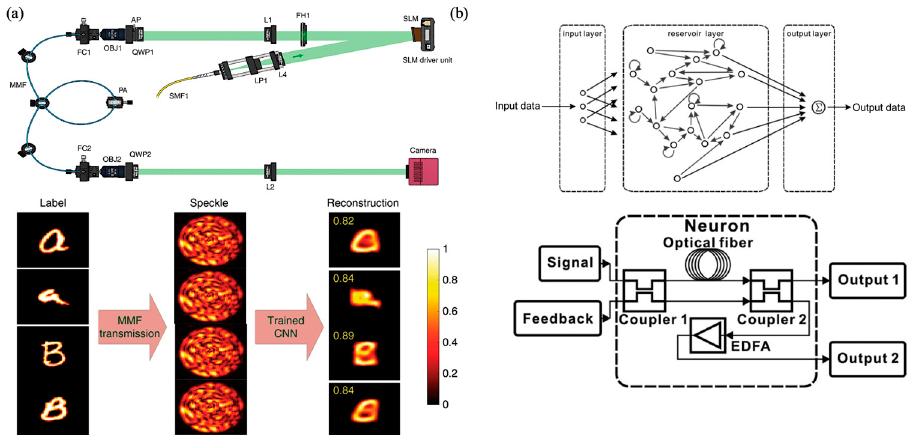
Figure 4. ( a ) CNNs project arbitrary patterns and perform transfer learning via MMF [89]. ( b ) MMF-based free-space all-optical RC system using spatial light modulators and diffractive optical elements [98].